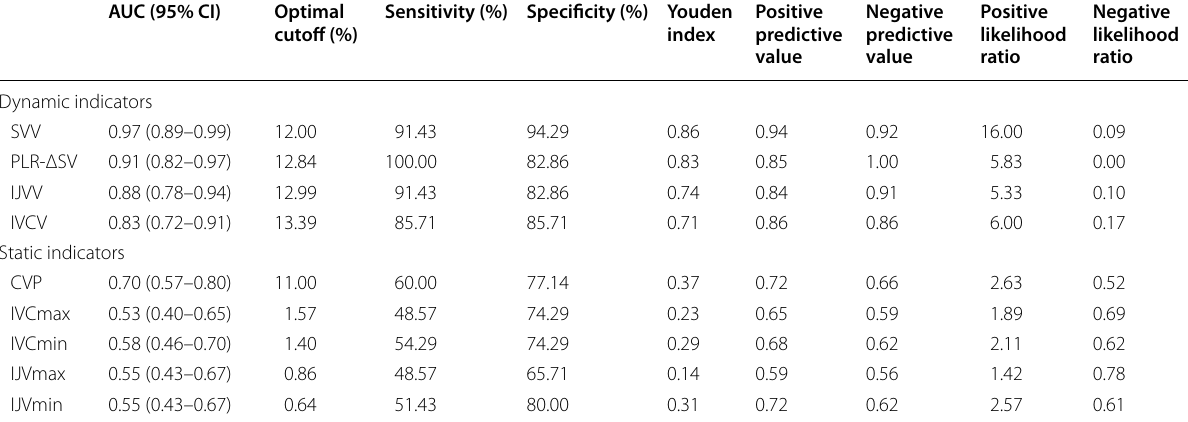
AUC area under the receiver operating characteristic curve, CI confidence interval, SVV respiratory variation of stroke volume, PLR -∆ SV the increase in stroke volume in response to a passive leg raising test, IJVV internal jugular venous variability, IVCV inferior vena cava variability, CVP central venous pressure, IVCmax the